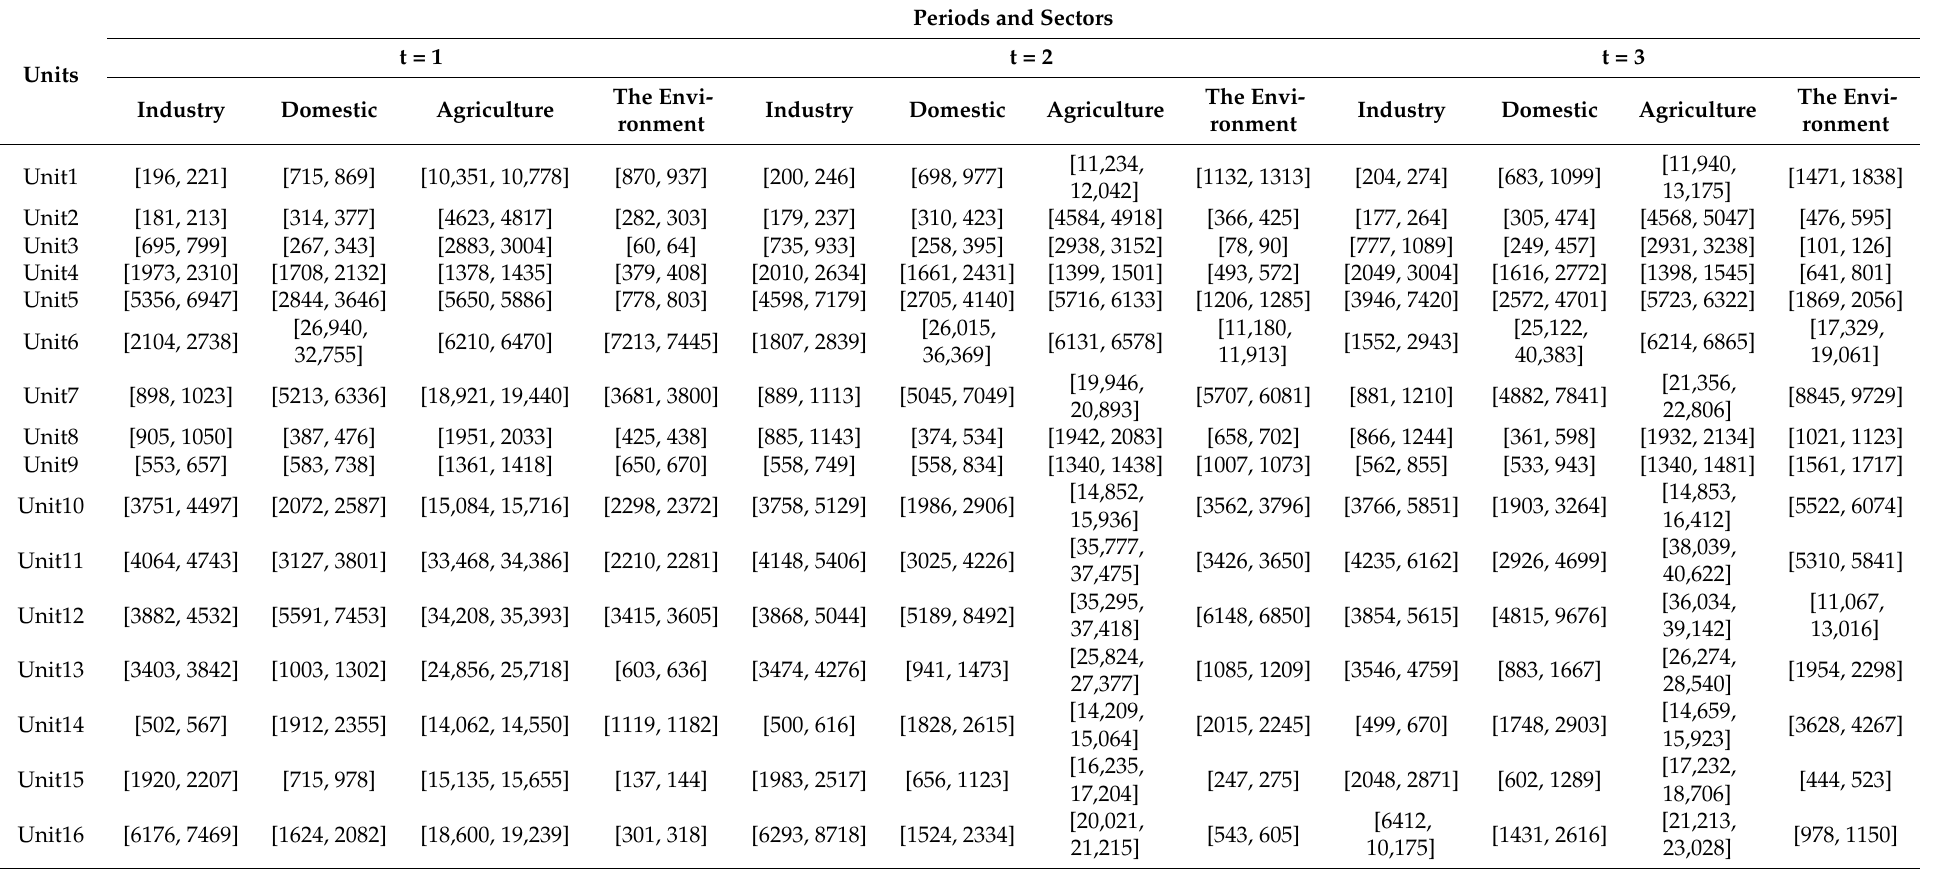
Table 2. Initial water resource allocation in the Fenhe River Basin (10 4 m 3